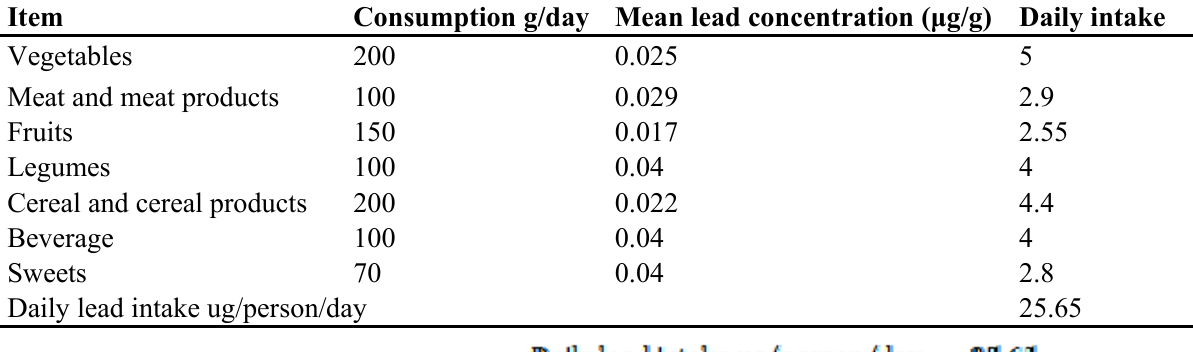
Table 6. Example for lead daily intake calculation from food